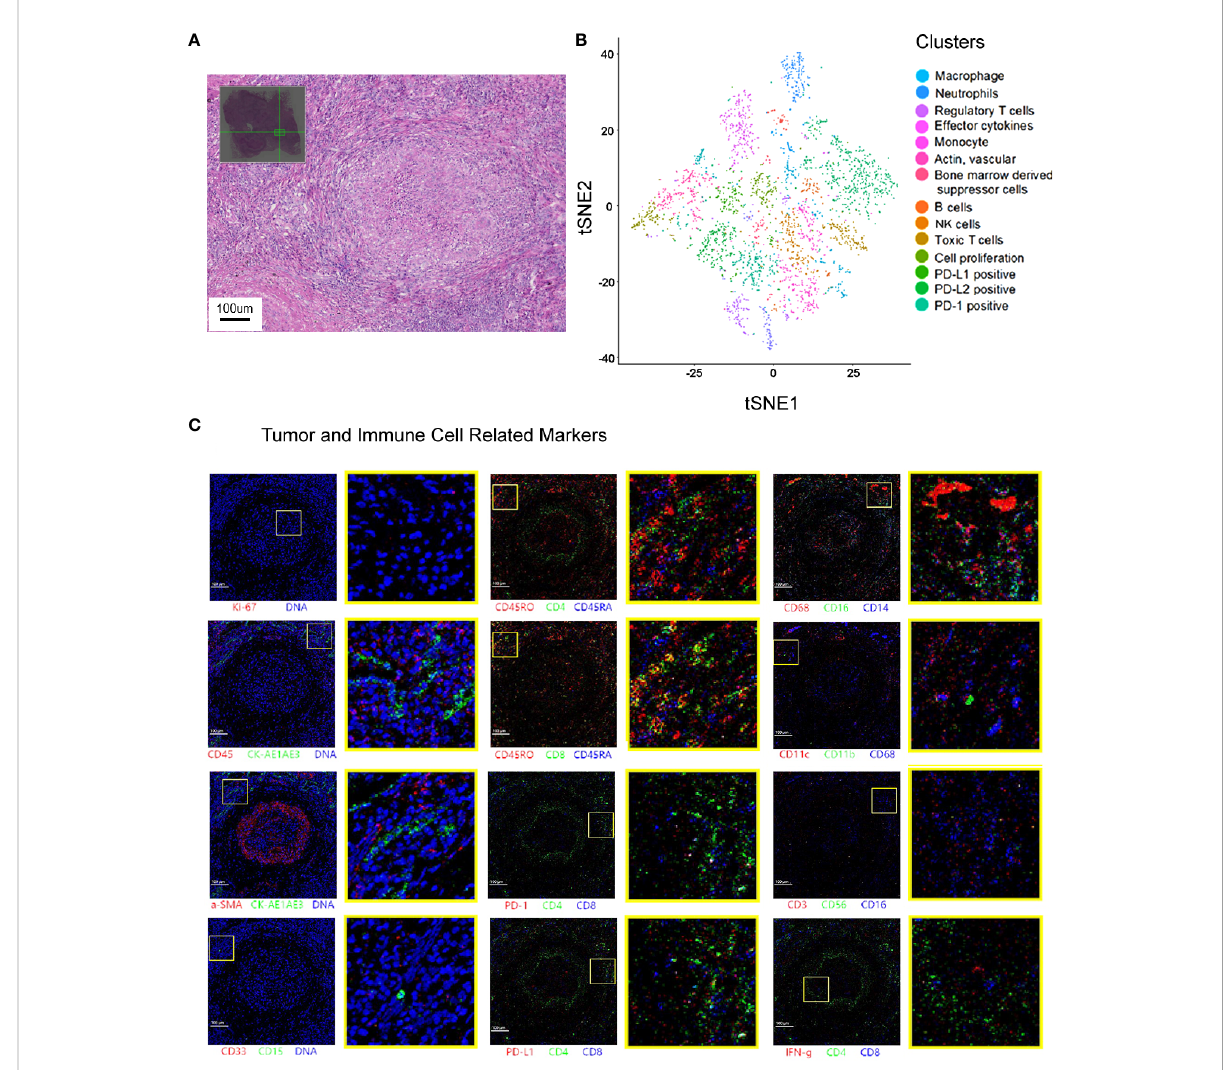
FIGURE 3 Spatial cell cluster analysis of the primary lesion scanned by Hyperion imaging mass cytometry. (A) The area selected for Hyperion tissue imager scan on a 5 mm × 5 mm formalin- fi xed, paraf fi n-embedded tissue slide. (B) Cell cluster analysis of the specimen. t-SNE descending dimension map of different cell types. (C) Imaging mass cytometry showing that the primary lesions in the lung were necrotic and in fi ltrated by multiple types of immune